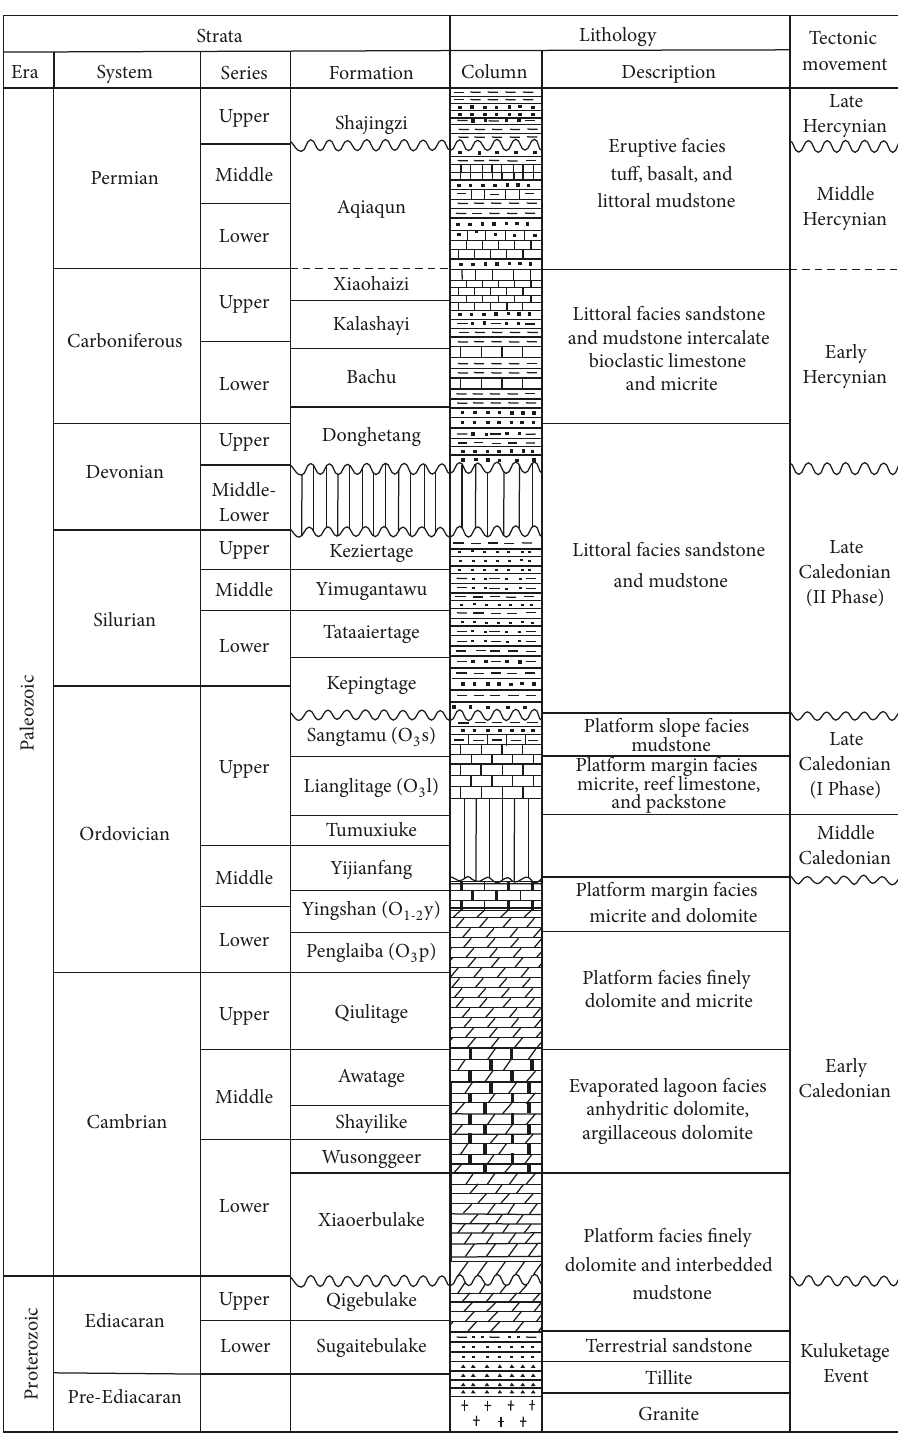
Figure 2: Stratigraphic column for the Tazhong